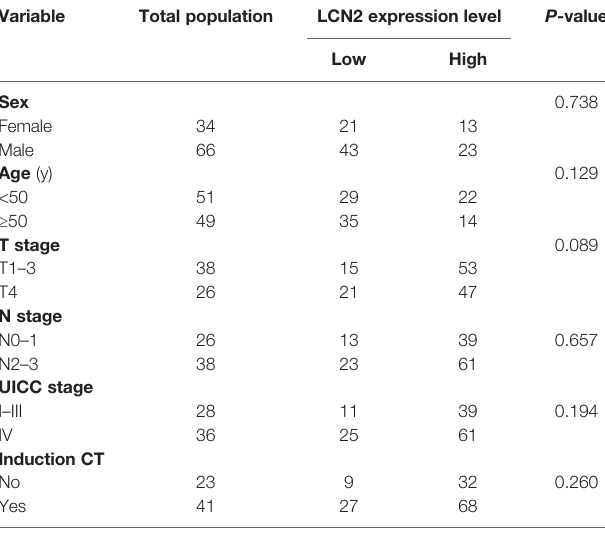
FIGURE 5 | The association between LCN2 expression and survival outcomes in nasopharyngeal carcinoma (NPC) patients. (A – C) Representative micrographs (×400) of normal nasopharynx mucosa (A) , NPC tissues with low LCN2 expression (B) , and NPC tissues with high LCN2 expression (C) are shown. (D – I) Kaplan – Meier analysis of the 5-year relapse-free survival (RFS), local relapse-free survival (LRFS), regional relapse-free survival (RRFS), distant metastasis-free survival (DMFS), progression-free survival (PFS), and overall survival (OS) between high and low LCN2 expression groups. The RFS and LRFS of patients with high LCN2 expression were signi fi cantly lower than those of patients with low LCN2 expression. There were no signi fi cant differences in RRFS, DMFS, PFS, or OS between the low and high LCN2 expression groups. TABLE 1 | The associations between LCN2 expression and clinicopathological parameters.